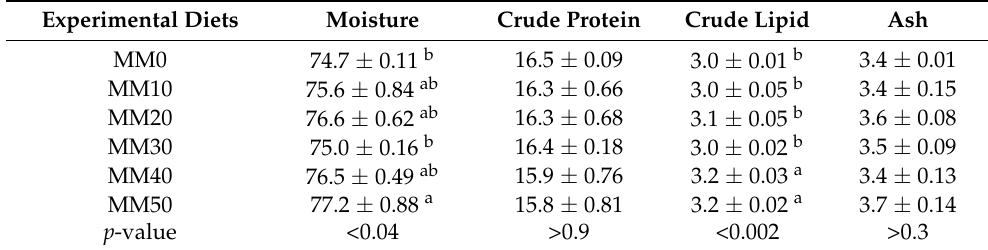
Table 5. Proximate composition (%) of the whole body of olive flounder fed experimental diets for 56